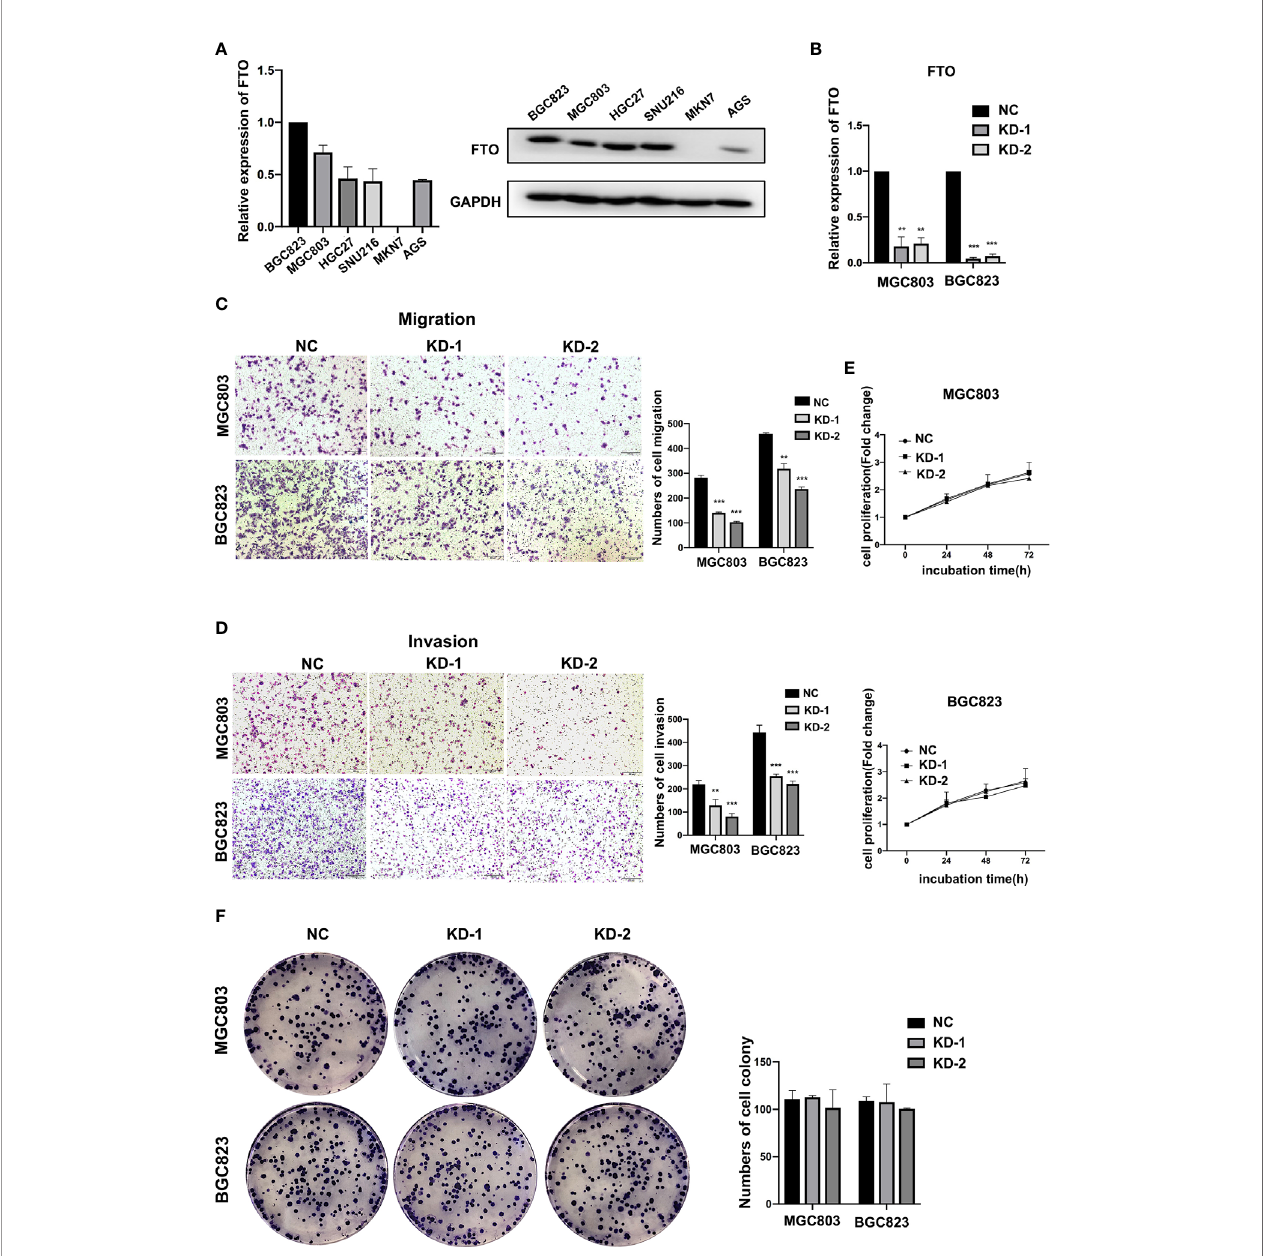
FIGURE 2 | FTO promoted GC cell migration and invasion. (A) The relative mRNA and protein expression of FTO in different gastric cancer cell lines were detected by qRT-PCR and Western blot. (B) The knockdown ef fi ciency of FTO in BGC823 and MGC803 cells was detected by qRT-PCR. (C, D) The migration and invasion ability of BGC823 and MGC803 cells after transfected with siNC or FTO siRNAs was examined by transwell assay (original magni fi cation, 100×). The columns on the right are quanti fi ed by counting 3 fi elds, and presented as the mean ± standard deviation. (E, F) The proliferation ability of BGC823 and MGC803 cells after transfected with siNC or FTO siRNAs was examined by MTT and colony-formation assay. The columns are presented as the mean ± standard deviation. Data are presented as the mean ± SD of three independent experiments. ** P < 0.01, *** P < 0.001. 18S was used as an internal control for all qRT-PCR experiments. GAPDH was used as an internal control for all western blot